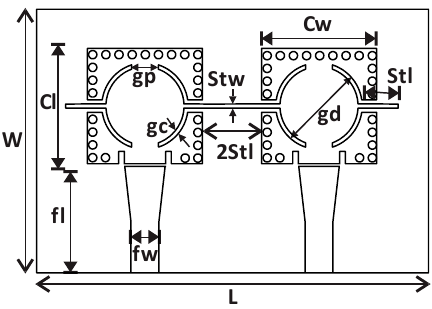
Figure 1. SIW filter with loosely coupled feed lines; dimensions are (in mm): L = 47, W = 32, Cl = Cw = 14, fl = 12.75, fw = 3.63, gp = 3.6, gc = 0.5, stw = 0.5, stl = 4.4, gd = 10.5.